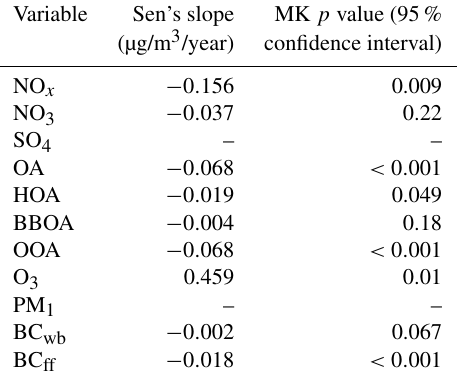
Table 1. Sen’s slope (in µg/m 3 /year) and MK p value for each vari- able of the study. No slope means that the result does not reach the 95% confidence interval. The slope is statistically significant for p < 0 .